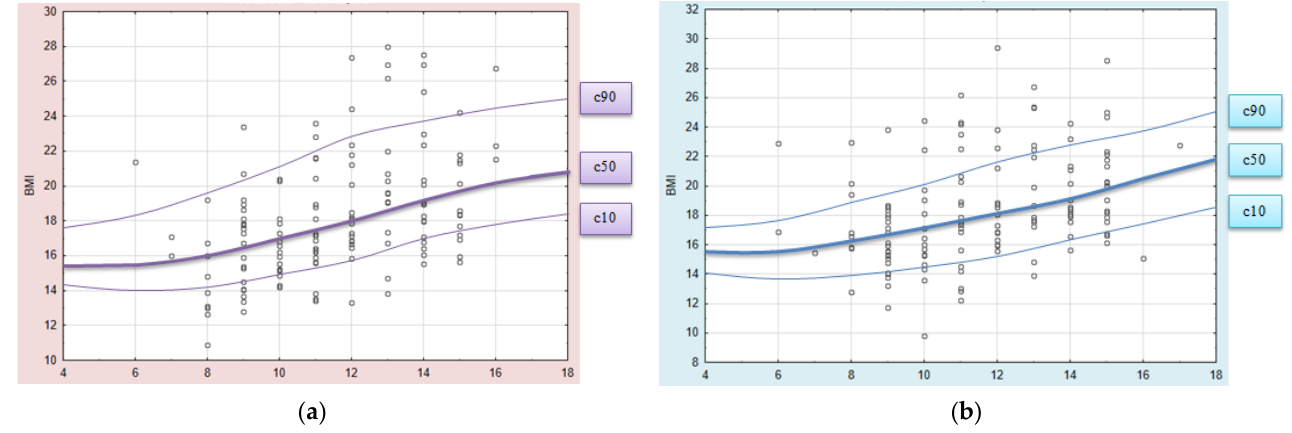
Figure 1. Graph of BMI distribution by age and gender ( a ) Graph for girls; ( b ) Graph for boys. For both girls and boys, the majority of parents reported no change in weight—50.3% weight had increased—33.6% of girls and 32.4% of boys (Figure 2).